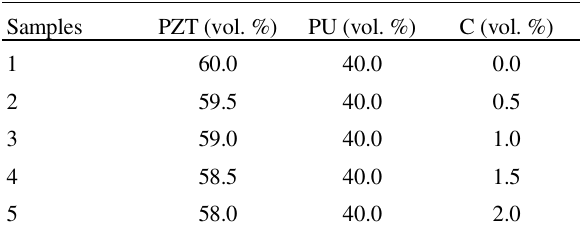
Figure 2. Piezoelectric activity as a function of semiconductor phase Table 1. Composites composition: Volume percent of semiconductor phase, PZT and PU.